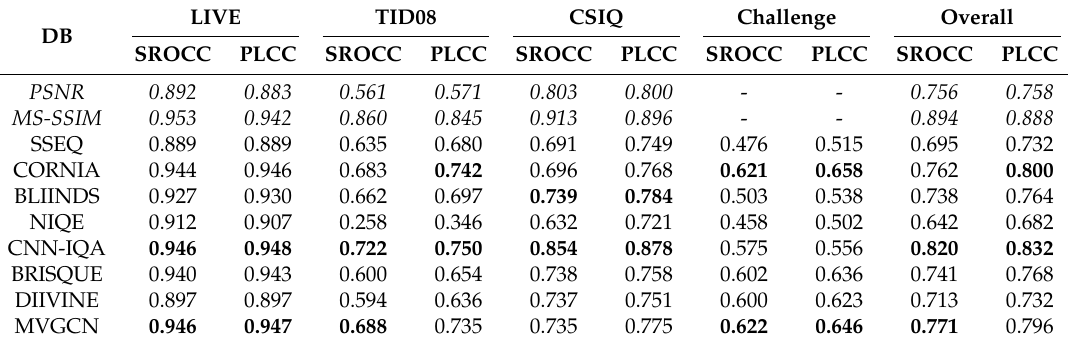
Table 2. Median Spearman’s rank ordered correlation coefficient (SROCC) and Pearson’s